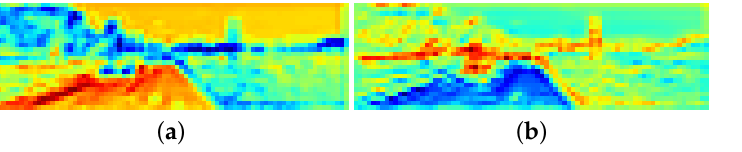
Figure 12. Model—ResNet-18, layer 34, total channels—64 , type—convolutional layer. ( a ) Channel 39. ( b ) Channel 114.